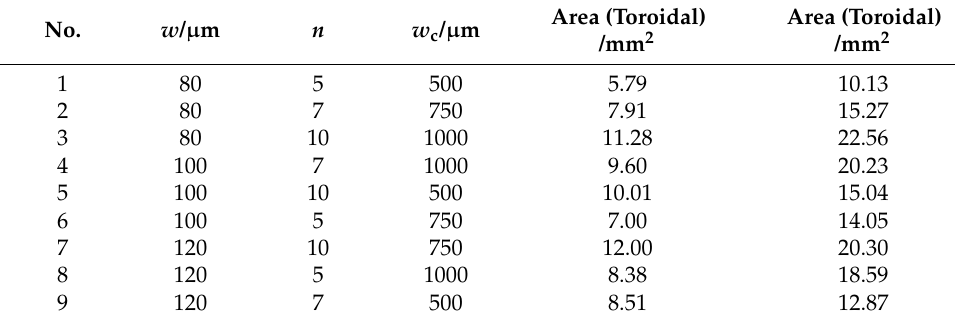
Table 1. Structure parameters of solenoidal and toroidal transformers.